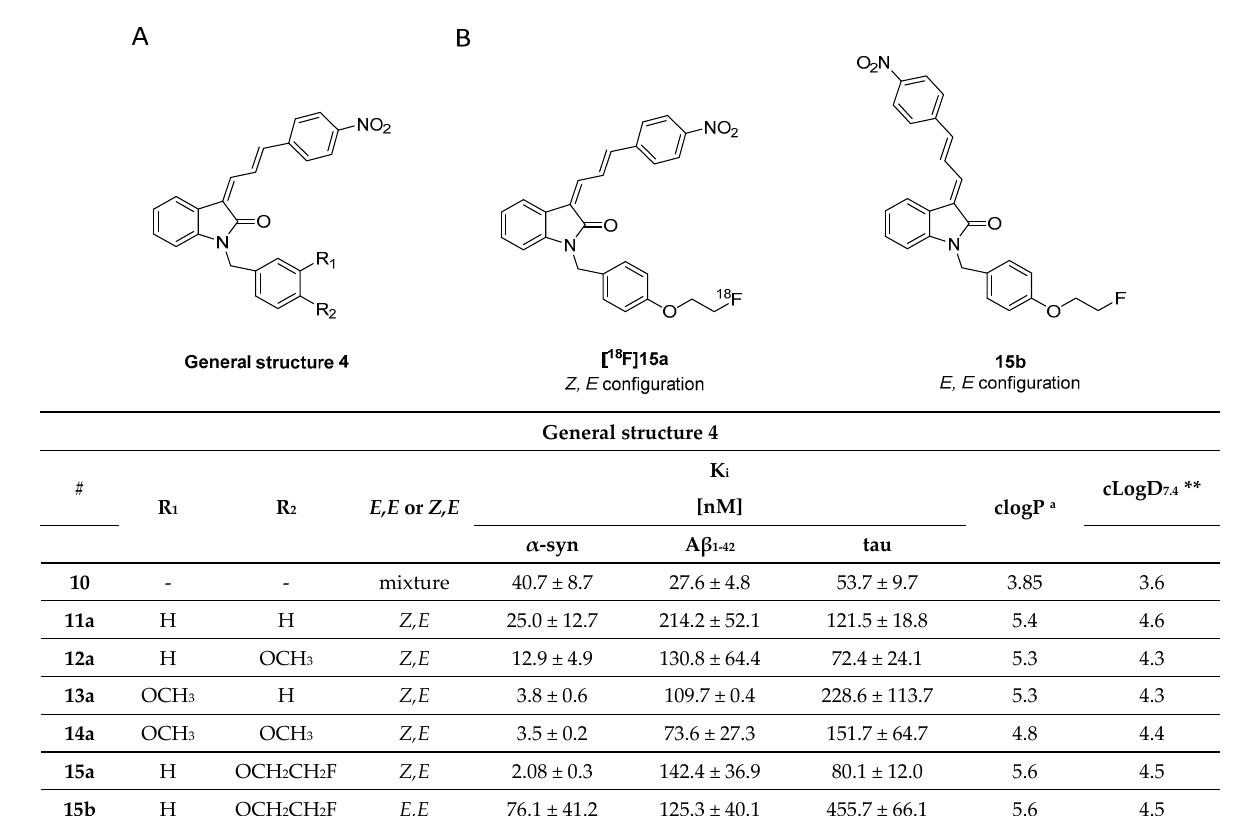
Figure 11. Chemical structures of indolidone-diene analogues with key properties. ( A ) General structure of indolidone-dienes and their binding affinity toward recombinant α -syn, tau, and synthetic A β 1–42 fibrils determined by ThT competitive binding assays [105]. a clogP were calculated from BioByte software. ** clogD 7.4 values calculated by ACD/Percepta. ( B ) Chemical structures of [ 18 F]15a ( Z,E configuration) and 15b ( E,E configuration) [105].